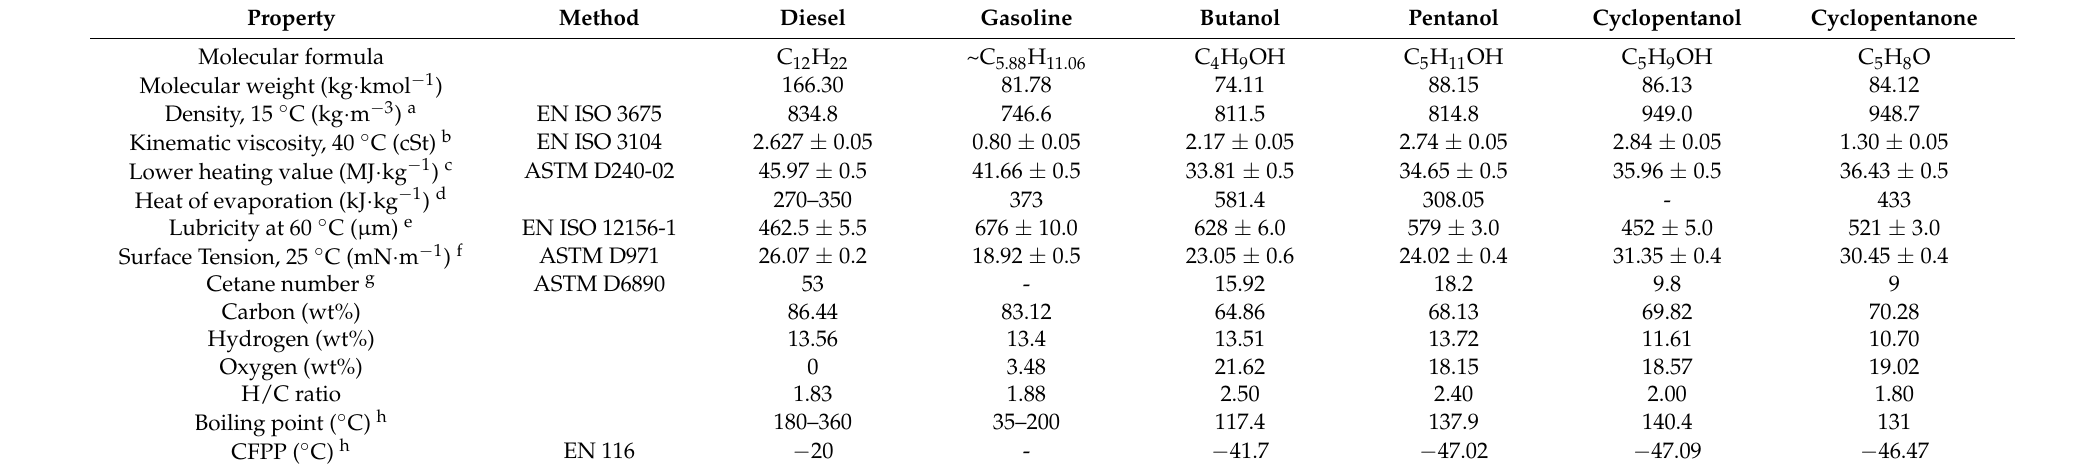
Table 1. Physical and chemical properties of neat tested fuels.